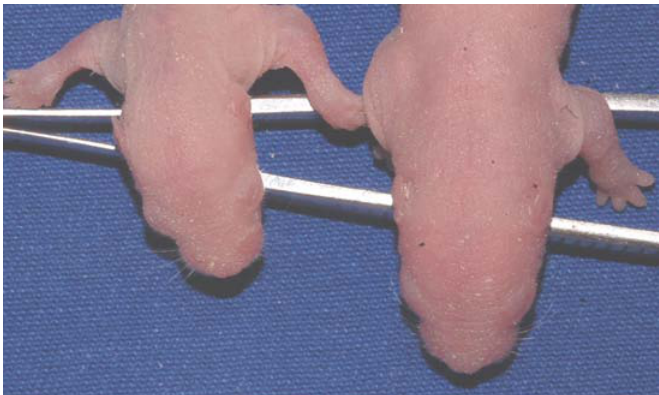
FIGURE 4 - The superior oblique view of a fetal head constrained pup and age-matched control pup. Note that the difference in longitudinal body size is quite significant